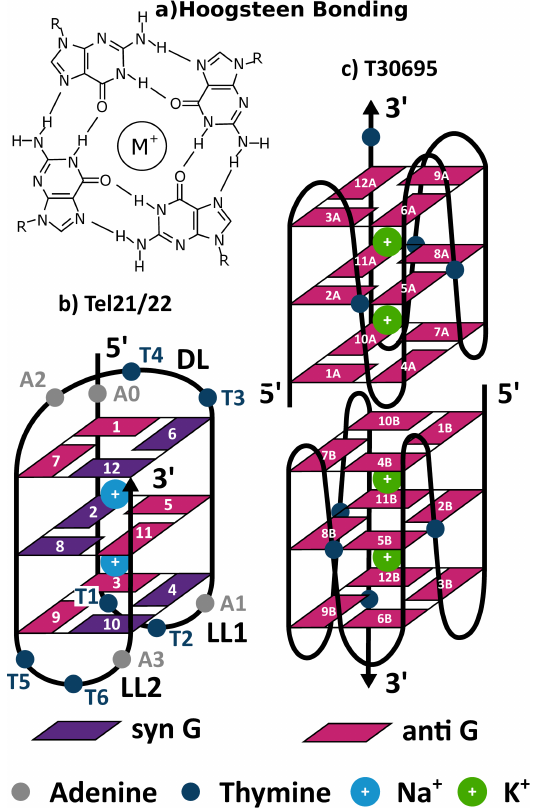
Figure 1. Schematic drawing of ( a ) Hoogsteen bonding arrangement of four guanines within a tetrad and the guanine quadruplex structures of ( b ) Tel21/22 (antiparallel) and ( c ) T30695 (parallel dimer). Only the guanine bases are numbered and labelled for T30695, both for monomers A and B. The adenine and thymine bases are numbered in addition to the guanines for Tel21/22, with Tel21 not including the 5 (cid:48) terminal adenine A0. The two lateral loops (LL1 and LL2) are also indicated, as well as the diagonal loop